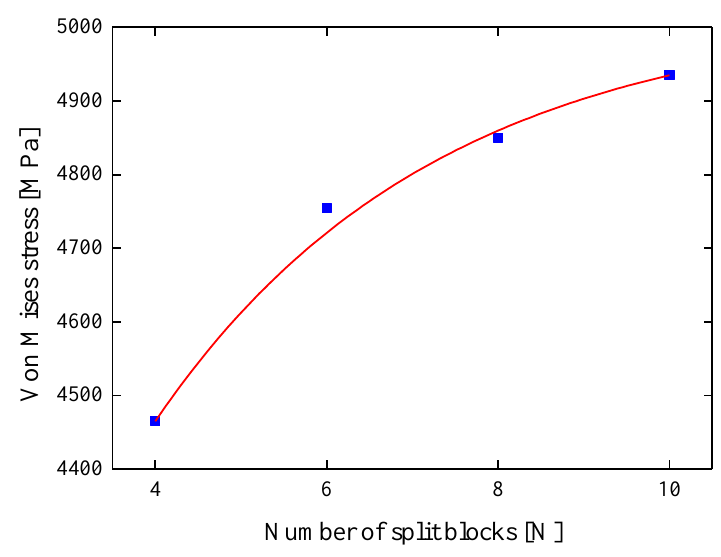
Figure 9. Magnitudes of von Mises stress on the cylinders with different numbers of split blocks.